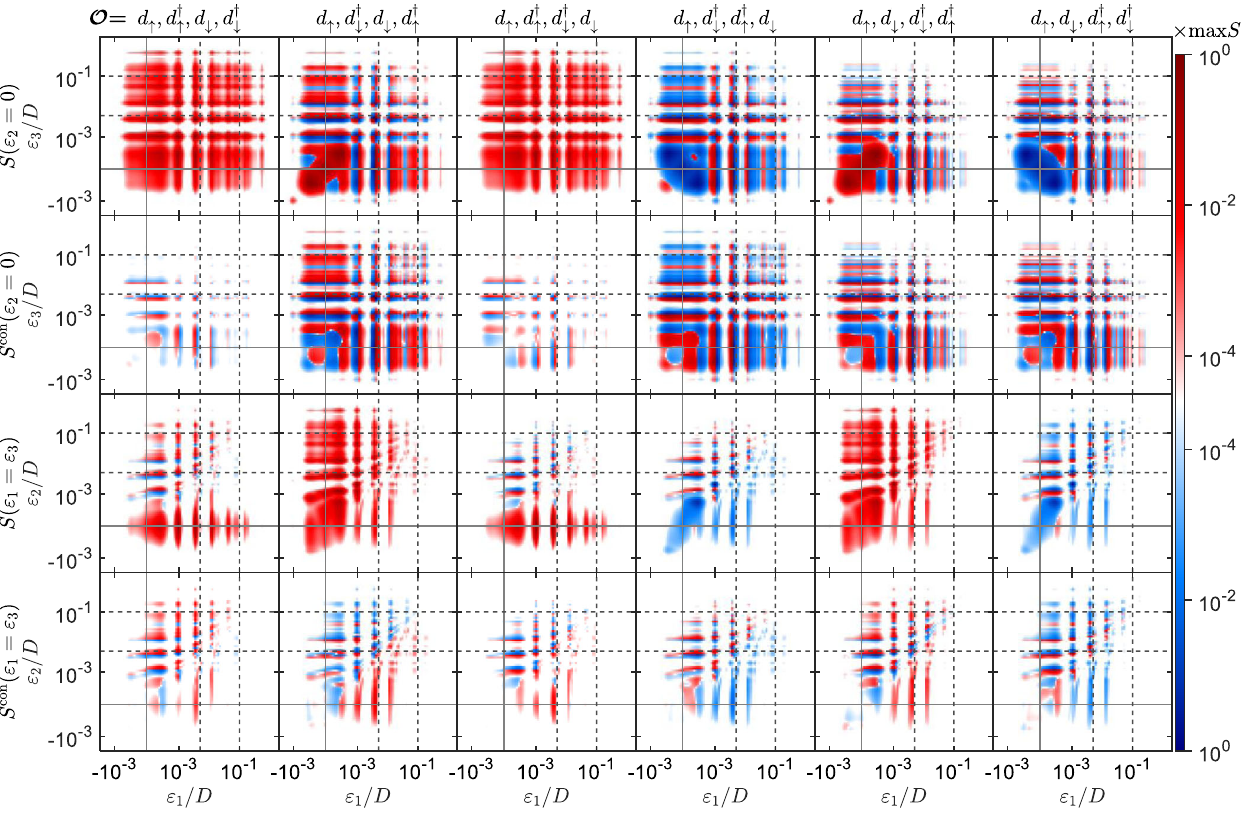
are related to those shown by spin and particle-hole symmetries. The p ε ε ε 1 and 2 along the cross section of 1 ¼ 3 . Odd rows show the full